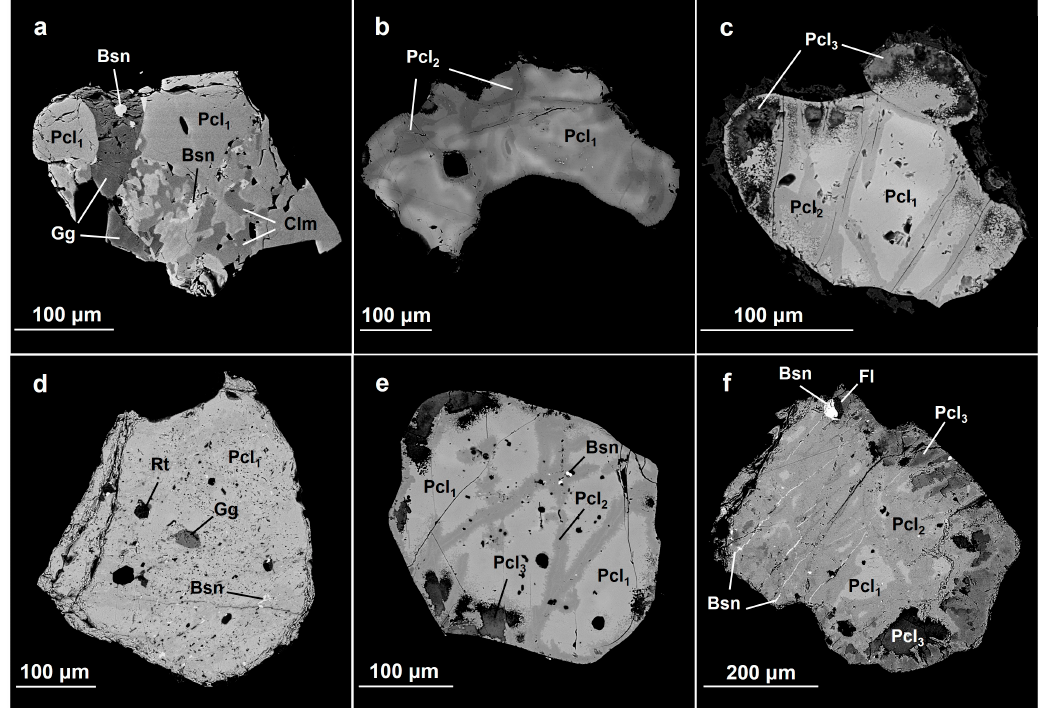
Figure 2. Pyrochlore-group minerals from the Katugin granites of different types (BSE image). ( a,b ): Bt-Arf granite; ( c ): Bt-Rbk granite; ( d ): Aeg-Arf granite; ( e,f ): Aeg granite. Mineral names are abbreviated as Bsn = bastnäsite, Clm = columbite, Fl = fluorite, Gg = gagarinite-(Y), Pcl 1 = primary pyrochlore, Pcl 2 = secondary-I pyrochlore, Pcl 3 = secondary-II pyrochlore, Rt = rutile.